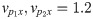
Peak power of STN firing rate ϕζ during a 40 s simulation within the frequency band f = 20–30 Hz using a time window t = 20–40 s.(a) Dependence of peak f = 20–30 Hz power on DBS pulse frequency with νζx = −1.2 mVs and vp1x,vp2x=1.2 mVs. (b) Change in peak f = 20–30 Hz power by a direct constant perturbation to the soma potential (dashed) and by an indirect perturbation resulting from an oscillating DBS input (solid), as described in Fig 2. For each point Vζ = Vζ + ΔV, Vp1=Vp1−ΔV, and Vp2=Vp2−ΔV.